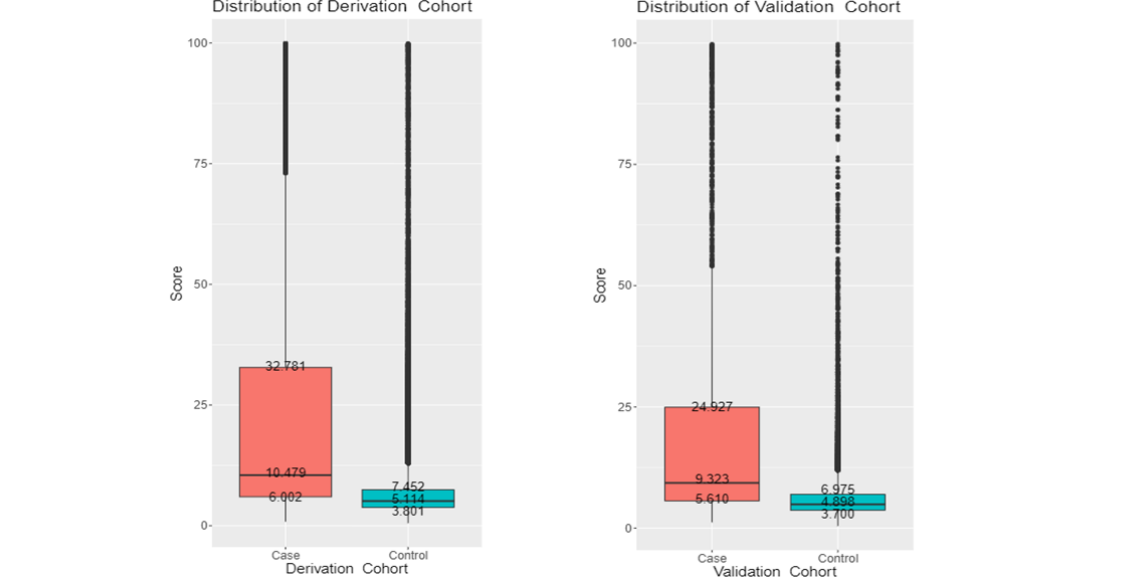
Figure 3. Risk score distribution. Left: Derivation cohort with CA-AKI stages 1-3 (case). Right: Validation cohort with CA-AKI stages 1-3